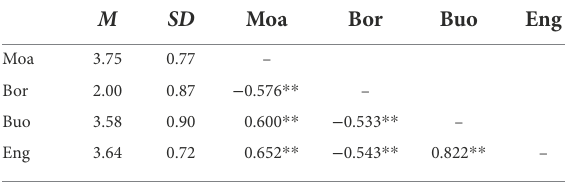
TABLE 1 Results of descriptive statistics and interrelations among